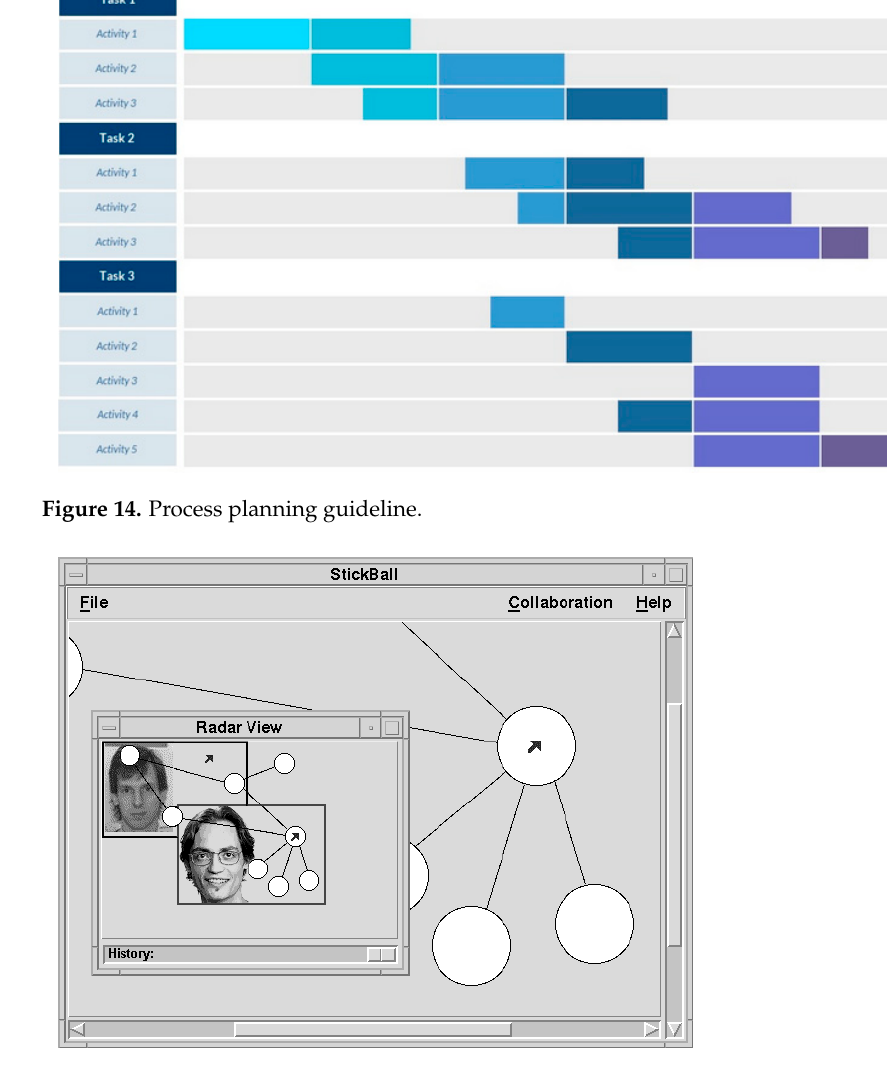
Figure 15. Spatial and semantic network guideline.